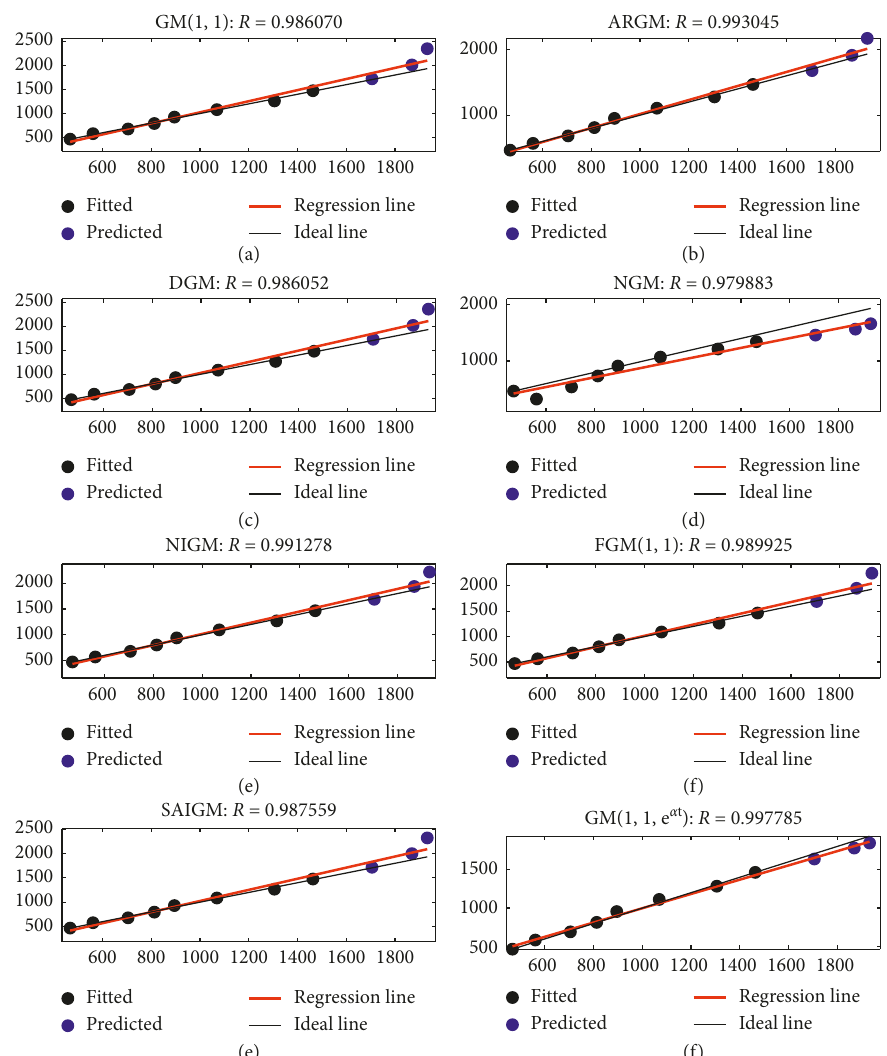
Figure 3: Comparison of the true value and the produced value by different grey models in Example A.